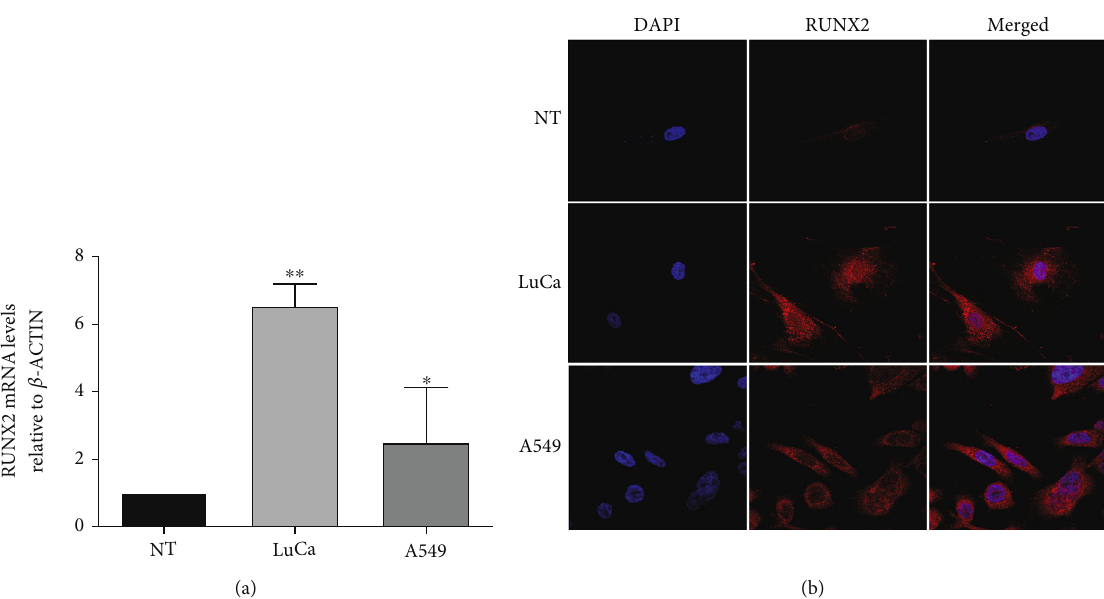
Figure 1: RUNX2 overexpression in lung cancer. (a) RUNX2 mRNA levels relative to β -ACTIN in lung cancer tissue (LuCa) and lung adenocarcinoma cell line A549 compared with noncancerous tissue (NT). mRNA levels were quanti fi ed by RT-qPCR. Statistical analyses were performed with respect to NT (three independent experiments) ∗ p < 0 : 05 , ∗∗ p < 0 : 01 . (b) RUNX2 protein expression by immuno fl uorescence assays. Images were obtained by confocal microscopy for immunolabelling of the RUNX2 protein (red, Alexa Fluor 546). For the visualization of the nuclei, the fl uorescent marker DAPI (blue) was implemented. Images were acquired with the Olympus FV100 confocal microscope with a 60x Plan APO oil